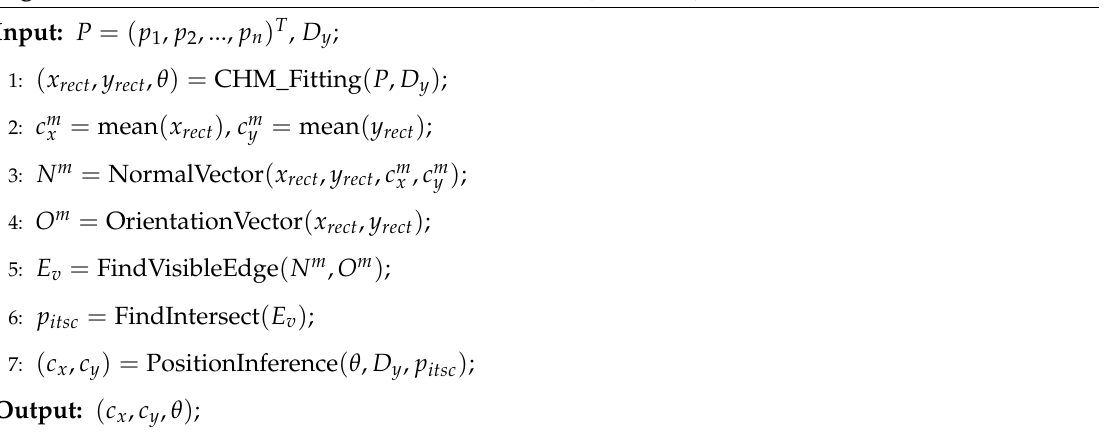
Algorithm 2 Pose estimation with convex-hull model (PE-CHM).